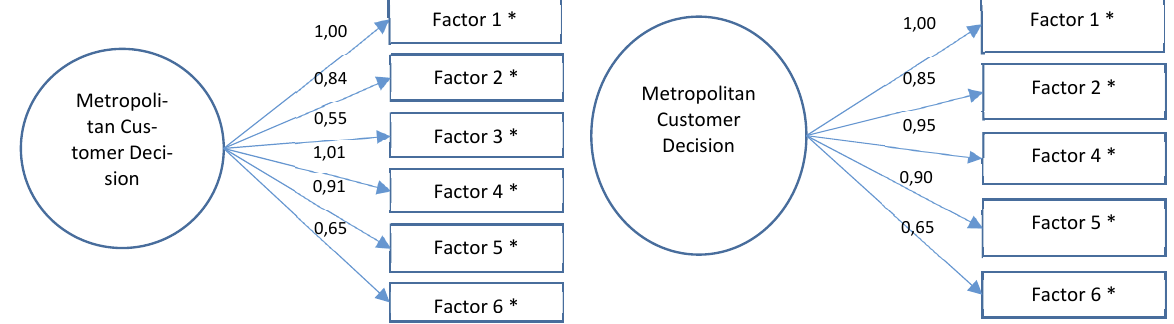
Fig. 3. Customer Decision Specification Model Fig. 4. Customer Decision Re-specification Model